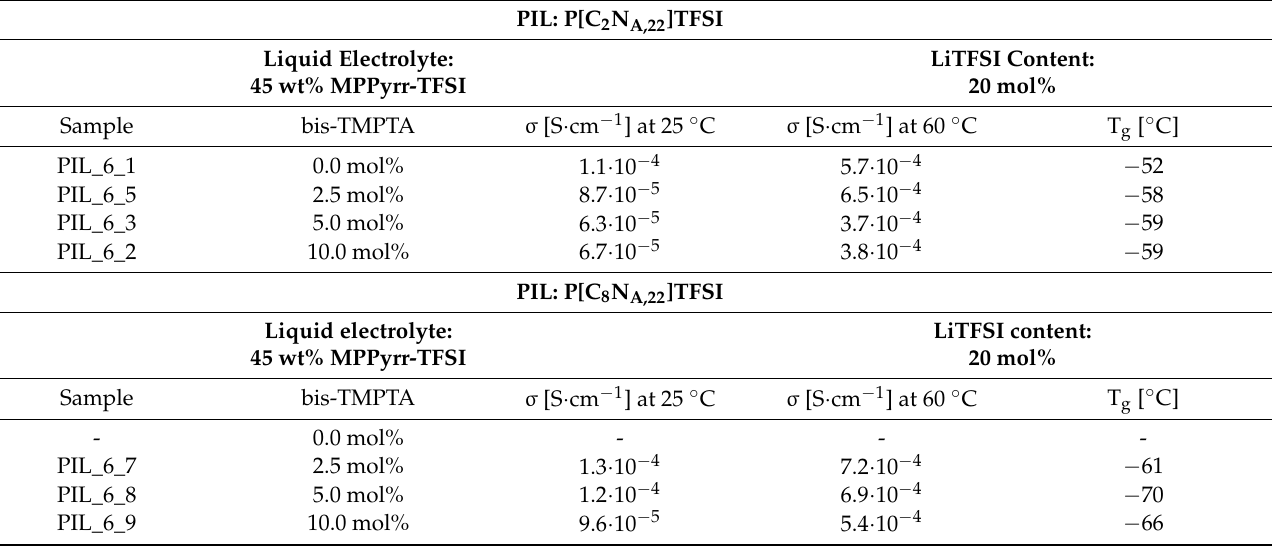
Table 1. wt % MPPyrr-TFSI and varying concentrations of the cross-linking agent. For this work, standard deviations are 16.7% for the determination of the ionic conductivity values. Glass transition values of complex material mixtures are only given as indications as described in the